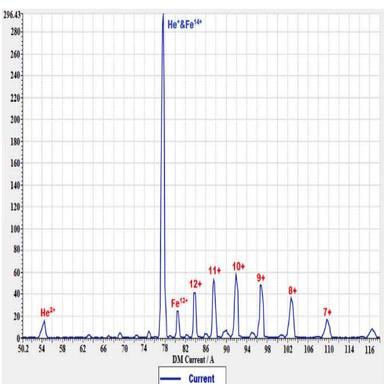
Spectrum of CSD with the optimized source for 56Fe14+ and 4 He+.